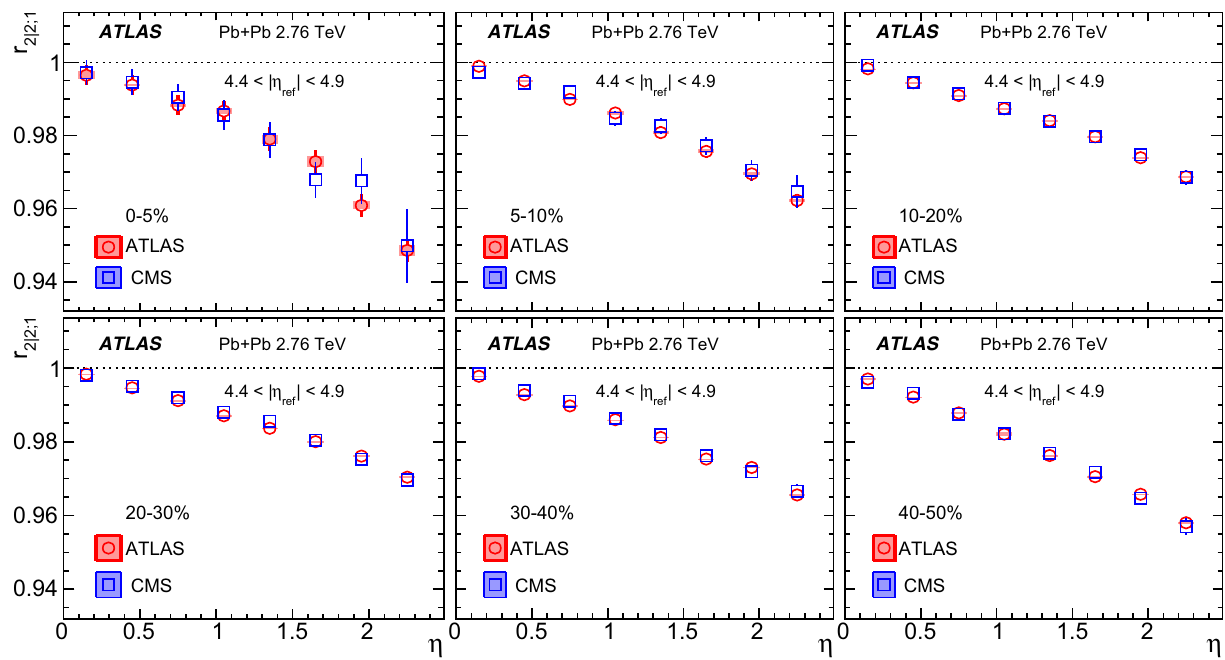
Fig. 25 The values of r 2 | 2 ; 1 measured by ATLAS and by CMS [19] for Pb+Pb collisions at 2.76 TeV, for the same reference pseudorapidity 4 . 4 < | η ref | < 4 .